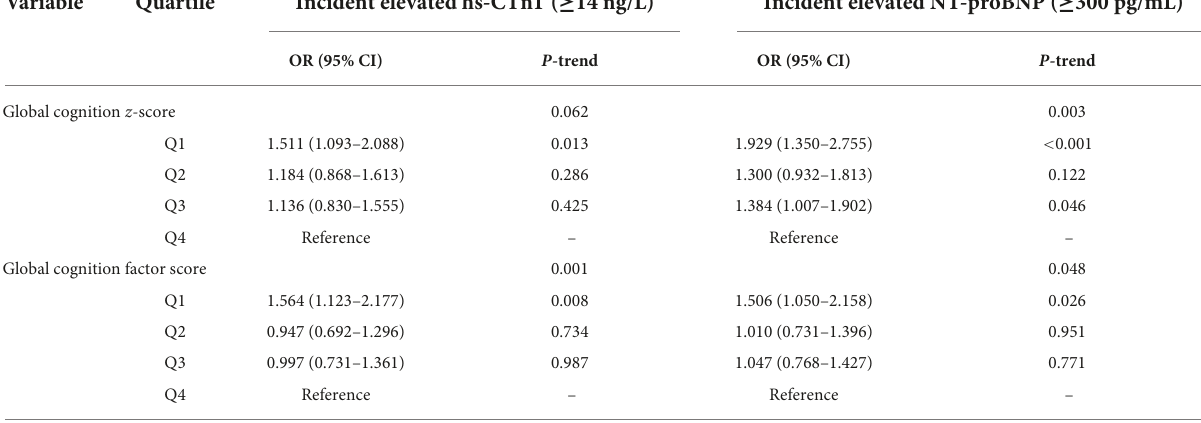
TABLE 2 Adjusted ORs (95% CI) for the association of baseline (1991–1993) cognition function with incident elevated hs-cTnT and NT-proBNP. Variable